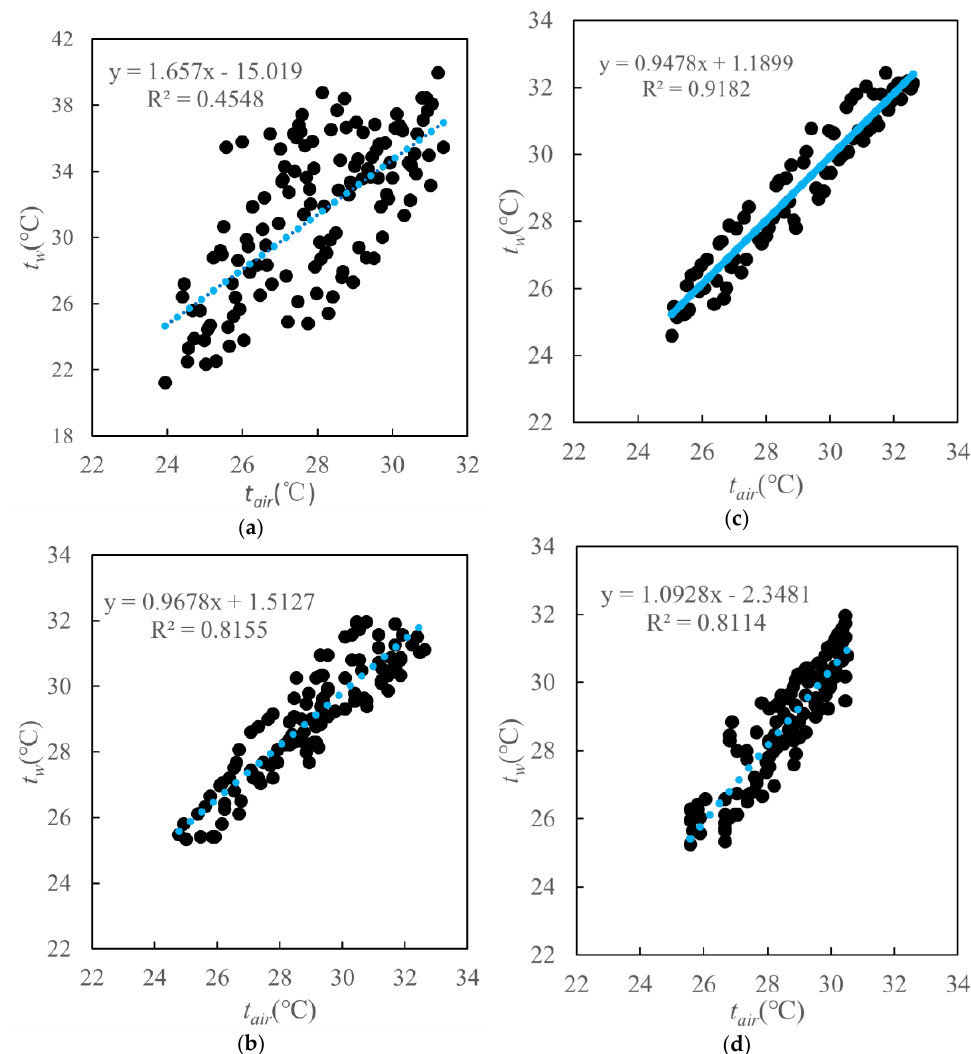
Figure 18. Relationships between indoor air temperature and surface temperature of each envelope. ( a ) Linear fitting of the surface temperature of the eastern inner wall and indoor air temperature; ( b ) linear fitting of the surface temperature of the south inner wall and indoor air temperature; ( c ) linear fitting of the surface temperature of the west inner wall and indoor air temperature; ( d ) linear fitting of the surface temperature of the north inner wall and indoor air temperature.